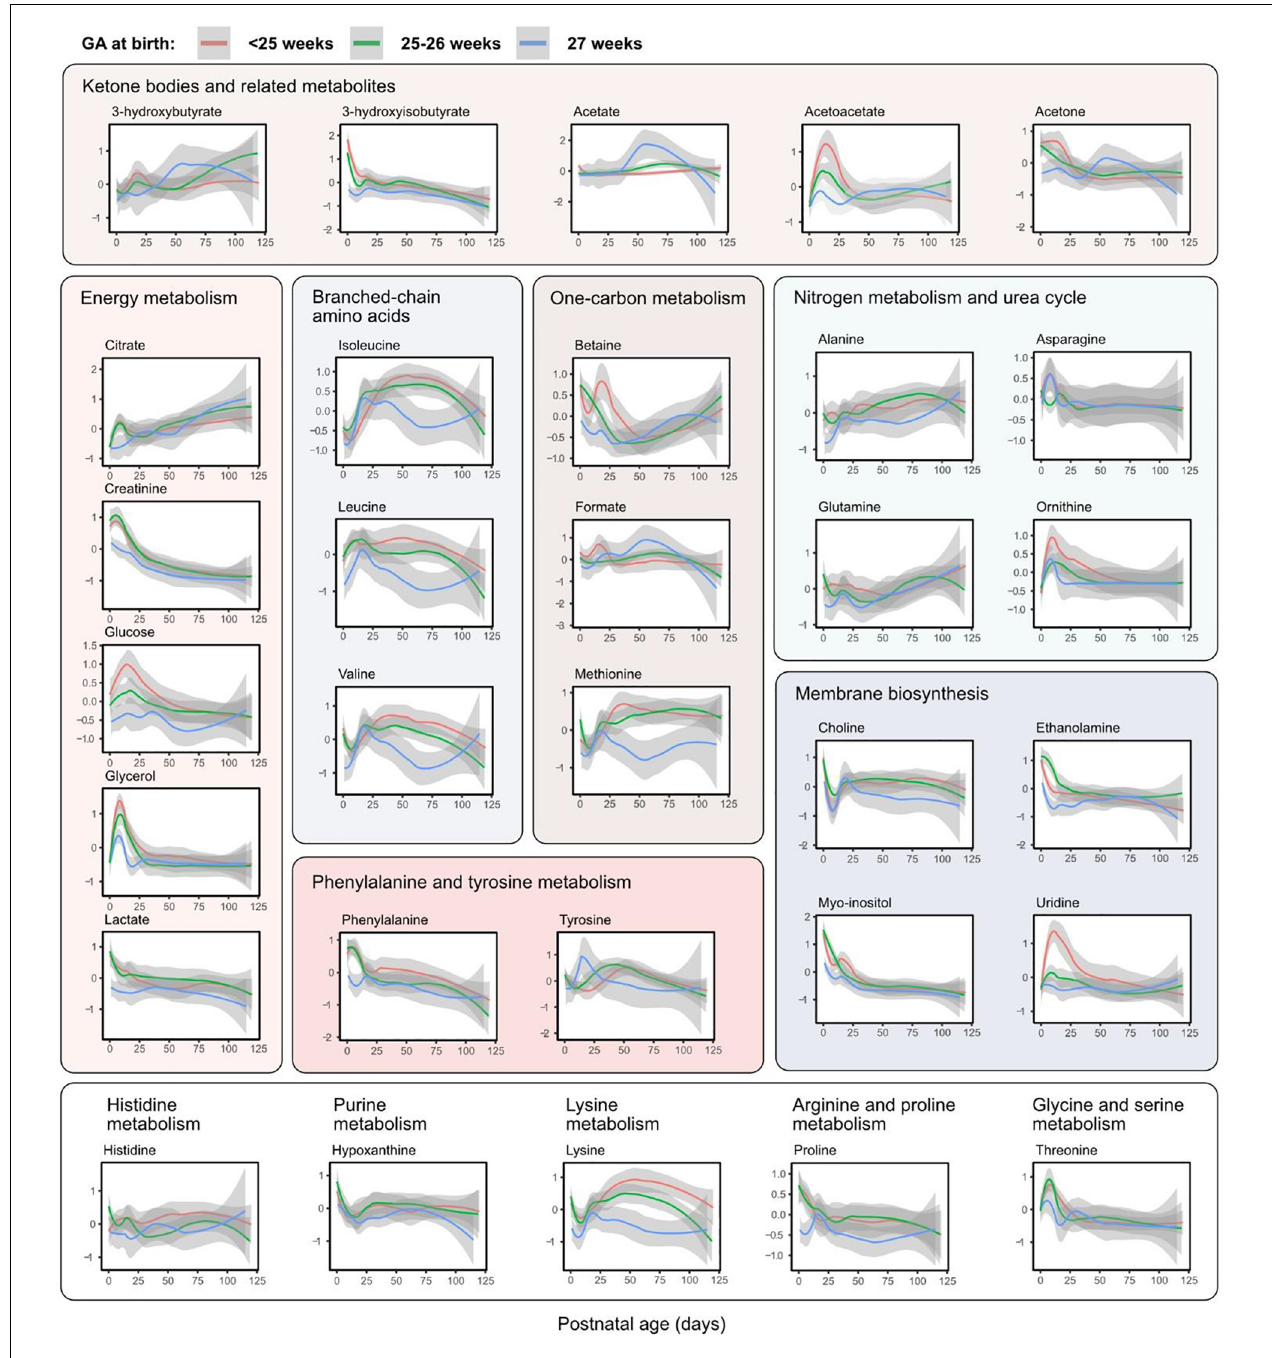
FIGURE 5 | Metabolite levels over postnatal age (days) by gestational age (GA) group. Accordingly to the legend, metabolite levels were stratified by GA at birth. Lines represent smoothed conditional means with 95% confidence intervals (shaded areas). Means are only shown up to day 120 due to few samples in each group at later time points. Y-axis shows z-score normalized metabolite